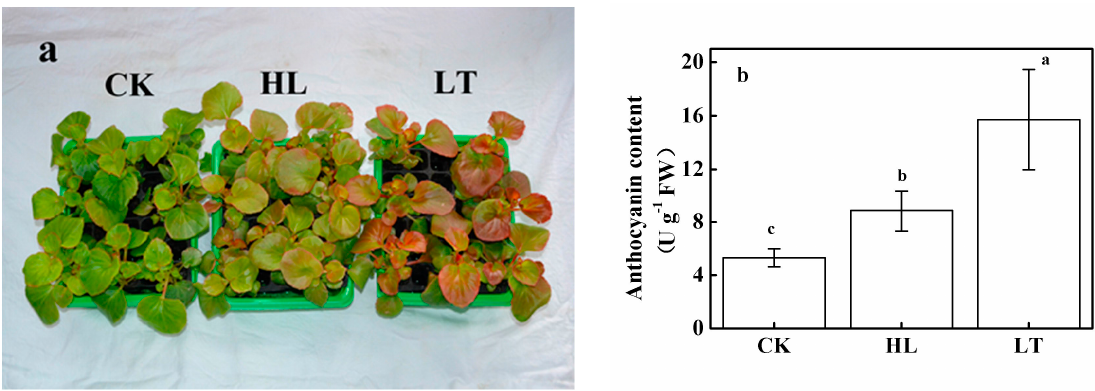
Figure 1. Phenotypes ( a ) and anthocyanin contents ( b ) in the leaves of B. semperflorens under different environmental conditions. Means denoted by the same letter (a, b, c) did not significantly differ at p < 0.05 according to Tukey’s test. LT, low temperature-treated plants; HL, high light-treated plants; CK, control plants; FW: fresh weight.